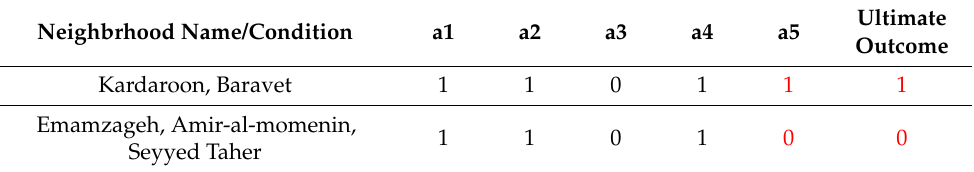
Table 5. INUS causes of the ultimate outcome. The absence of condition a5 resulted in recovery